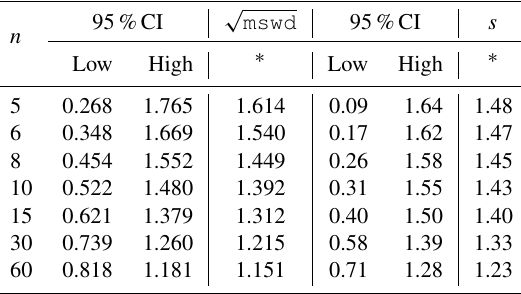
Table 1. The 95% confidence intervals for mswd and s , as a func- tion of the number of data points, n (see